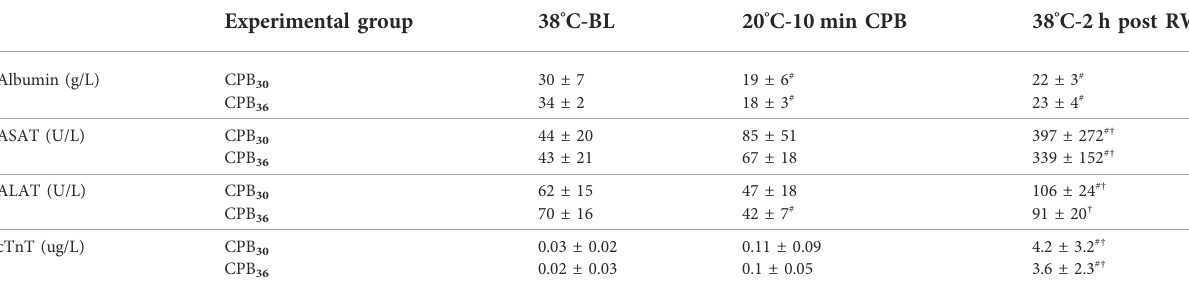
TABLE 1 Blood plasma albumin, ASAT, ALAT and cTnT values.